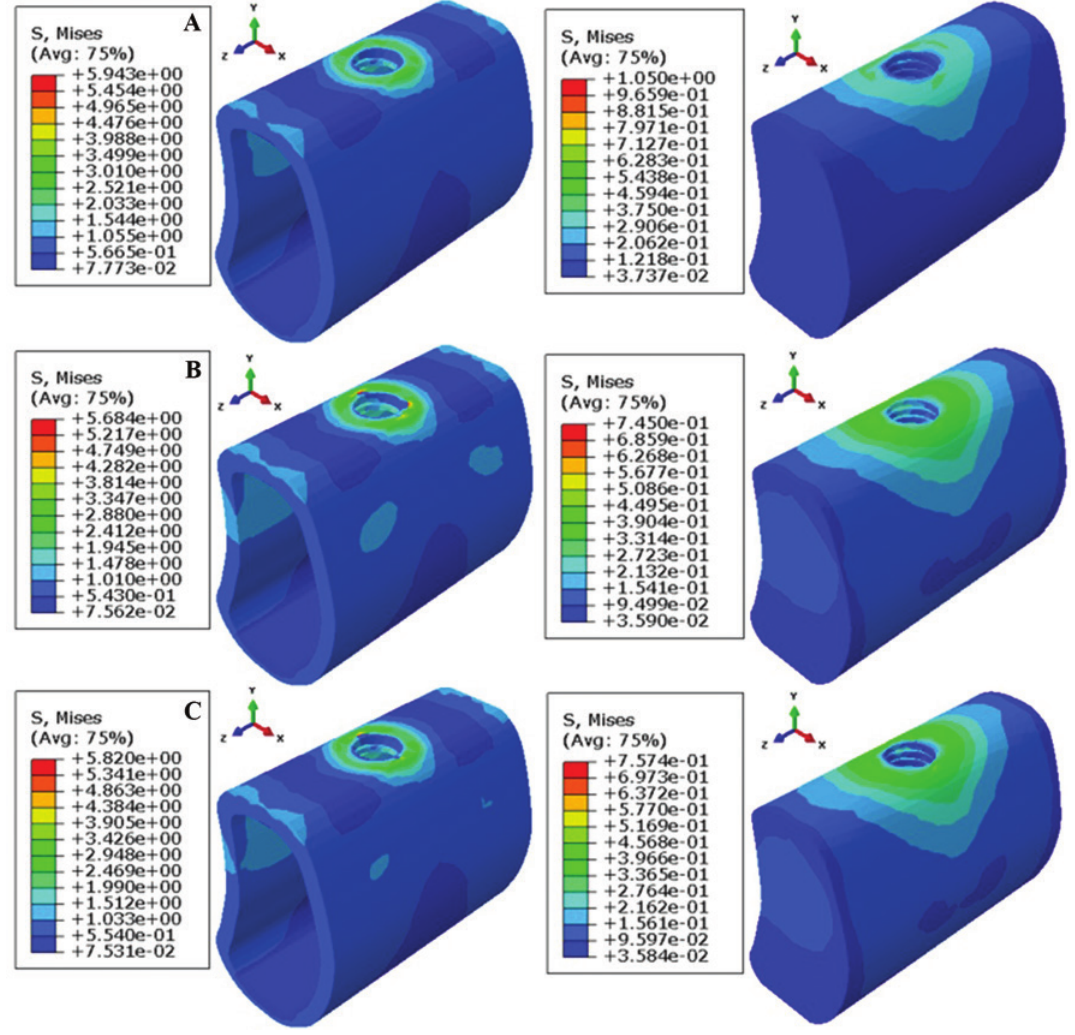
= 40 GPa), and (C) SFGM ( η = 10) out